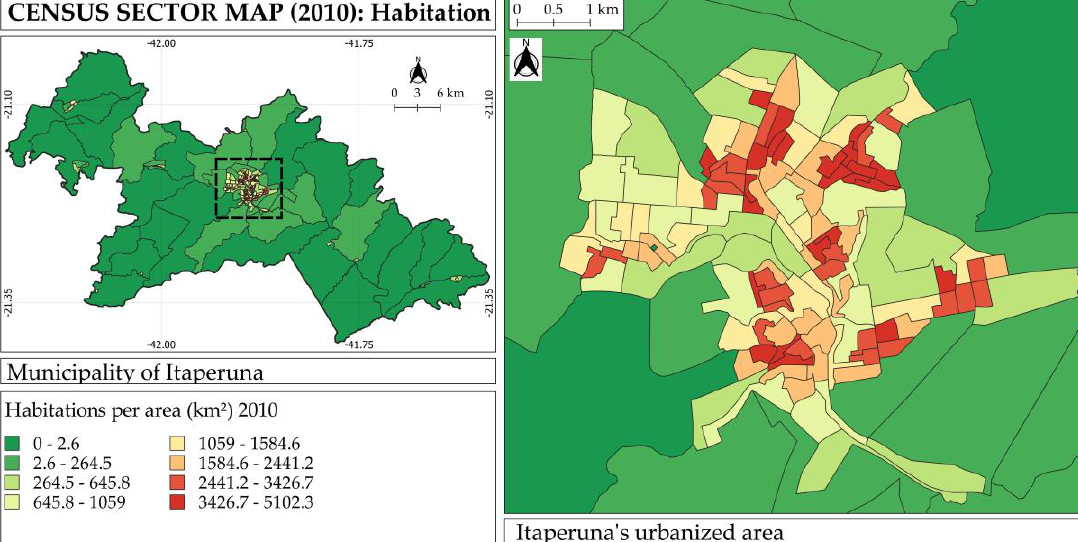
Figure 8. Census sector map of the municipality of Itaperuna: population per area released in 2010 [90].